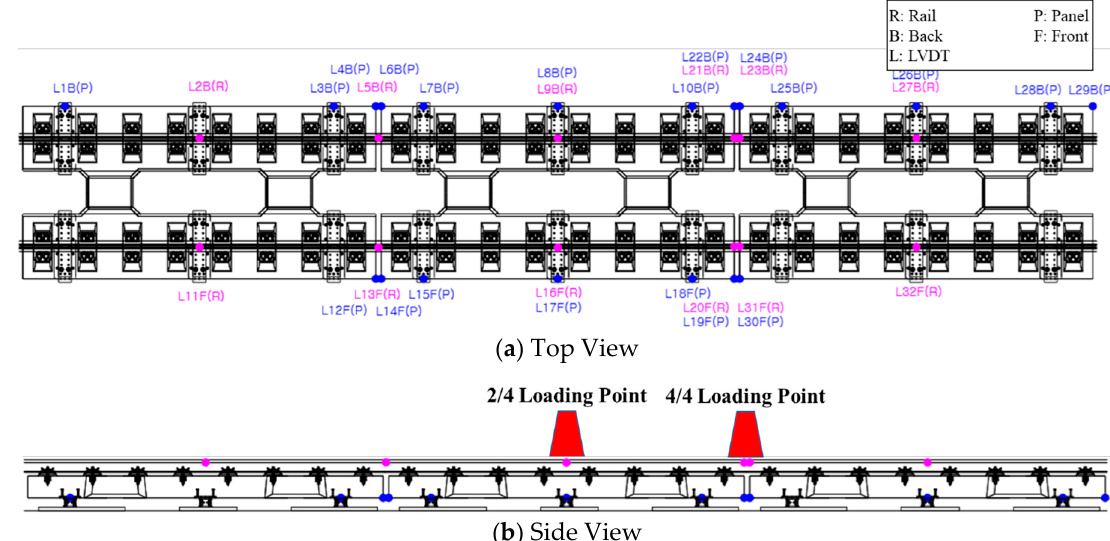
Figure 7. Locations of sensors to evaluate the performance of the three precast panels.